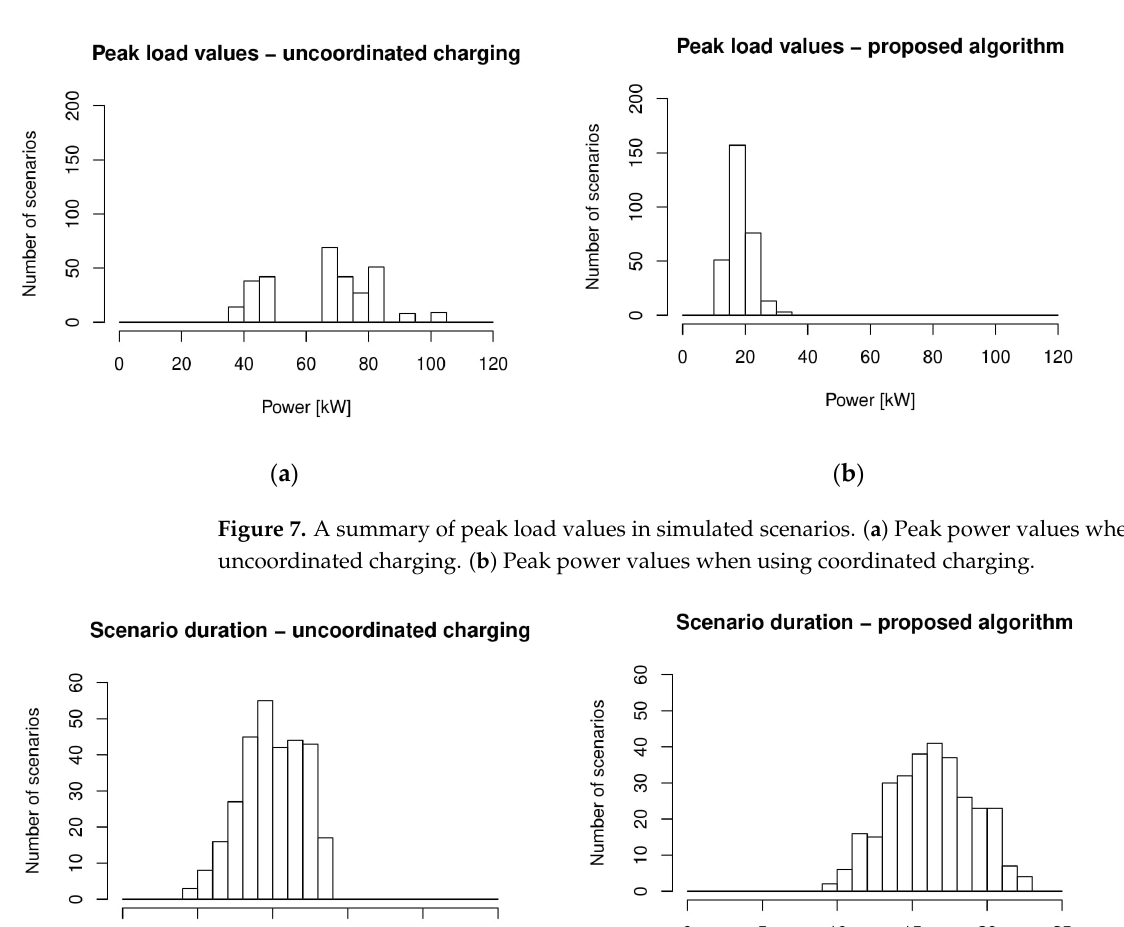
Figure 7. A summary of peak load values in simulated scenarios. ( a ) Peak power values when us- ing uncoordinated charging. ( b ) Peak power values when using coordinated charging.